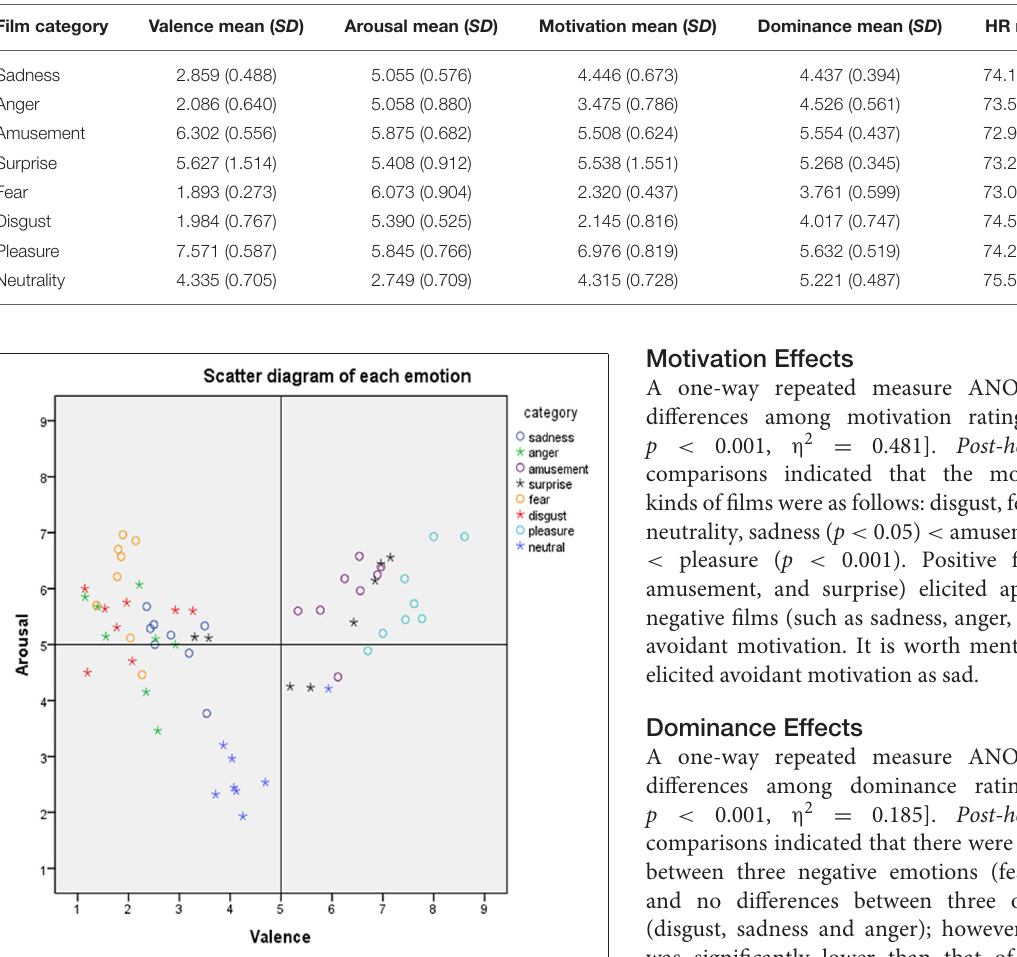
from each other. The valence ratings were as follows: